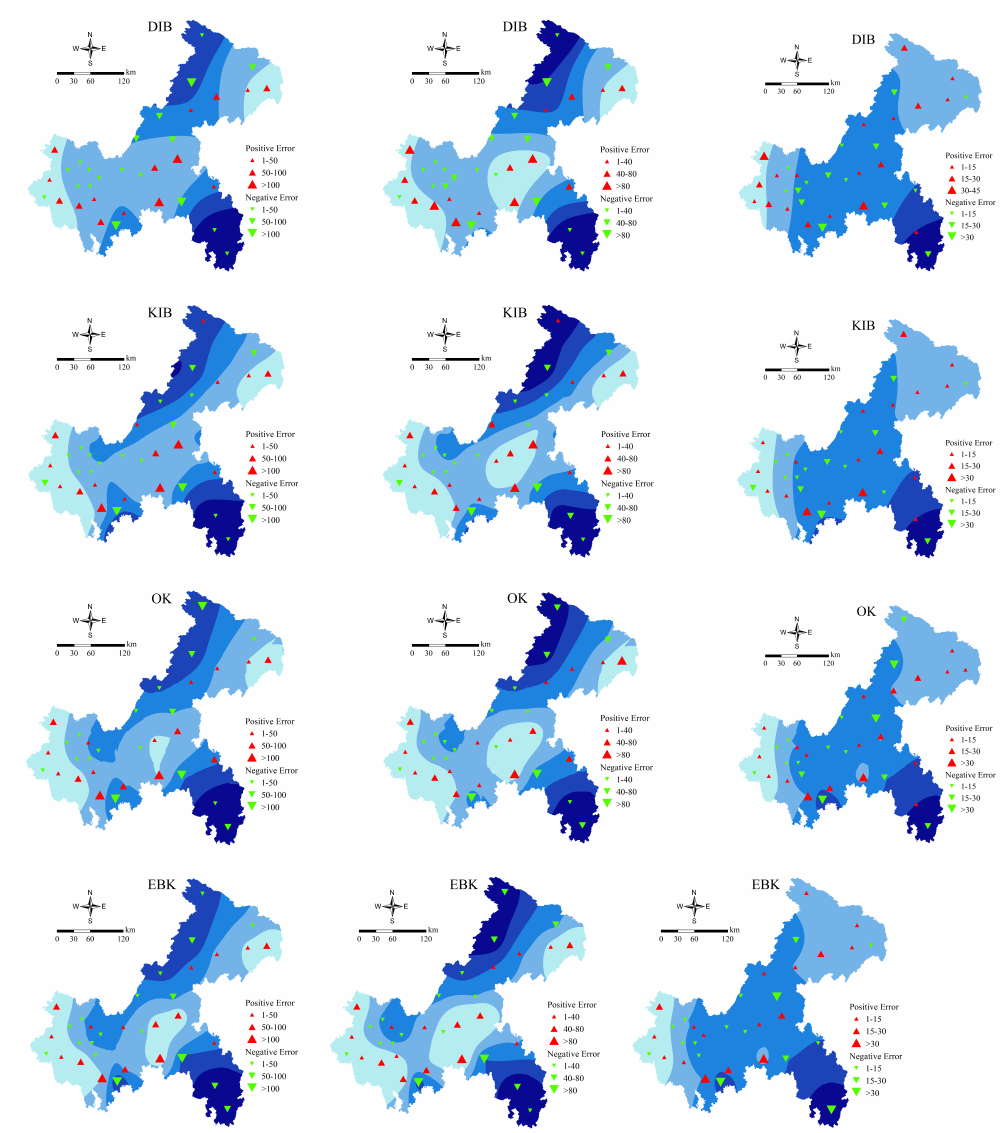
Figure 4. Spatial distribution of estimated errors under different climatic conditions based on six interpolation methods (IDW, RBF, DIB, KIB, OK, EBK): ( a ) mean annual; ( b ) rainy season; and ( c ) dry season. To further figure out the performance of six interpolation methods in replicating rainfall magnitudes under different climatic conditions, the absolute error distributions of different methods are presented as box plots in Figure 5. Red lines inside the box represent the median value of the absolute errors. Black dotted lines display the mean value. Red dots indicate outliers. The center represents the middle 50%, or 50th percentile, of the data set and was derived using the lower and upper quartile values [11]. The upper and lower whiskers of each box are drawn to the 90th and 10th percentiles [6], and the upper and lower edges of the rectangle (i.e., box) are defined as the 75th and 25th percentile of the data set, respectively